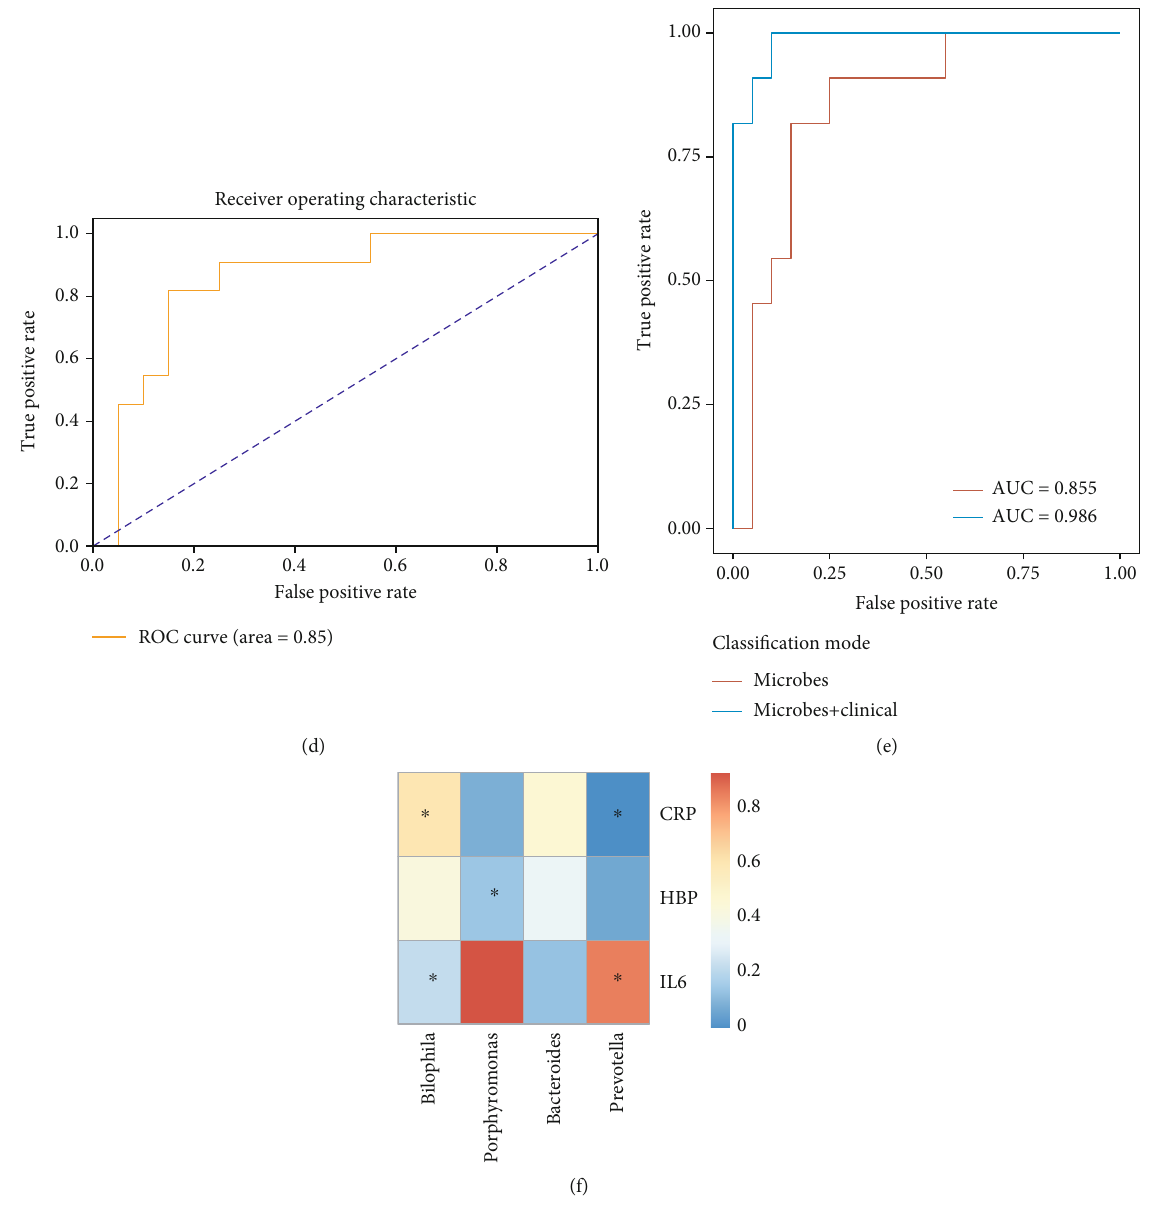
Figure 3: Microbial pro fi les of the gut microbiota in the sepsis (SEP) and healthy control (Ctrl) groups. (a). Relative abundances of the dominant phyla. (b). Relative abundances of the abundant genera. (c). Di ff erences in microbial genera between SEP and Ctrl groups.